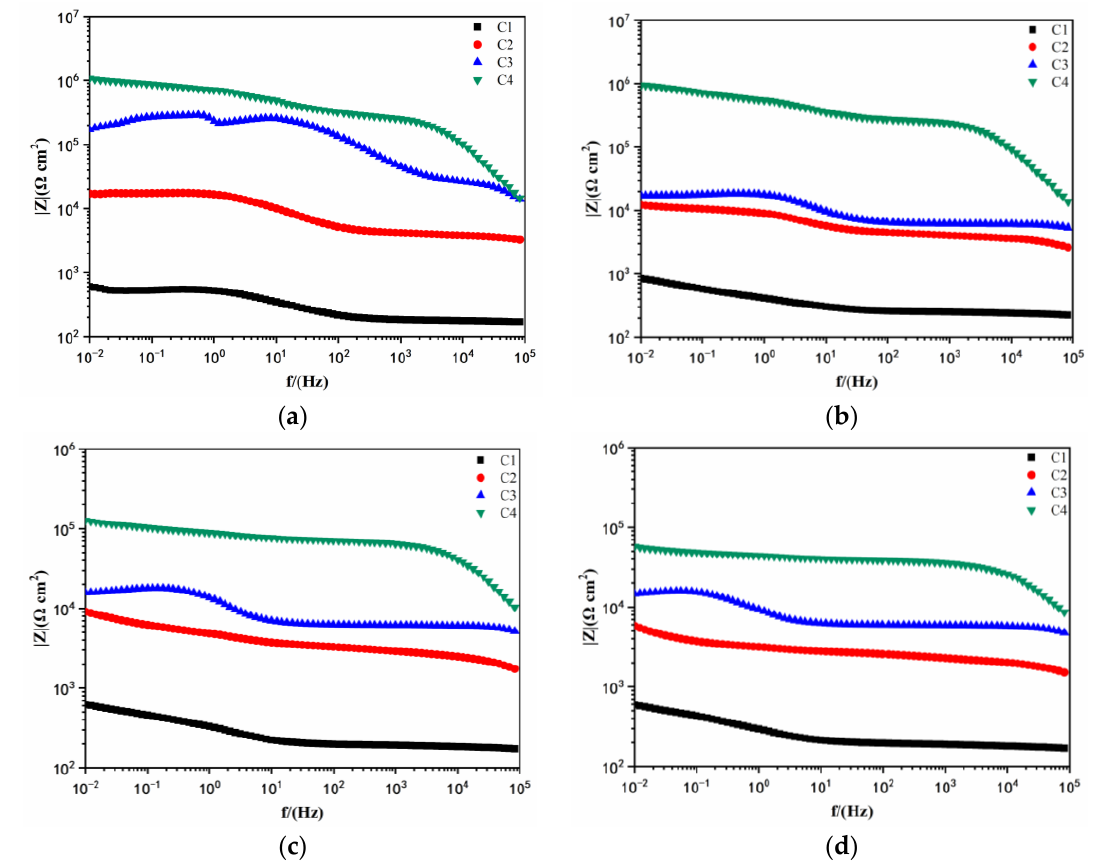
Figure 8. Bode pattern after immersion: ( a ) 1 d; ( b ) 11 d; ( c ) 21 d; and ( d ) 31 d.